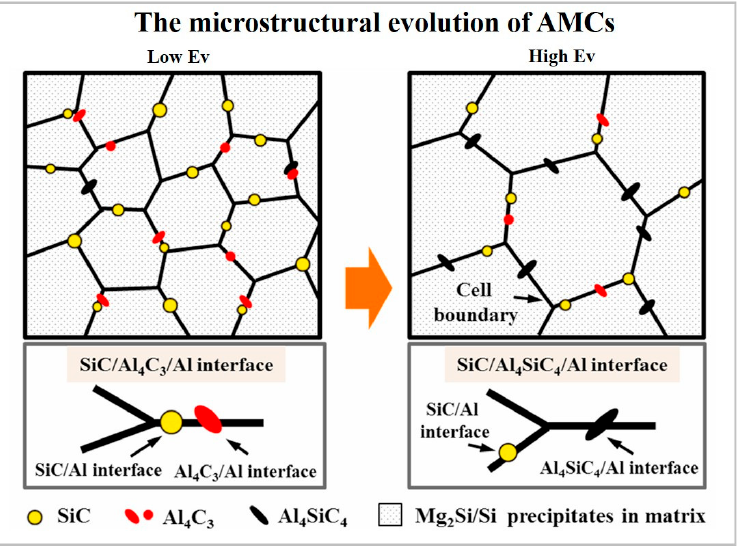
Figure 17. Microstructure changes of the composites at low to high energy application (reproduced with permission from [95]).